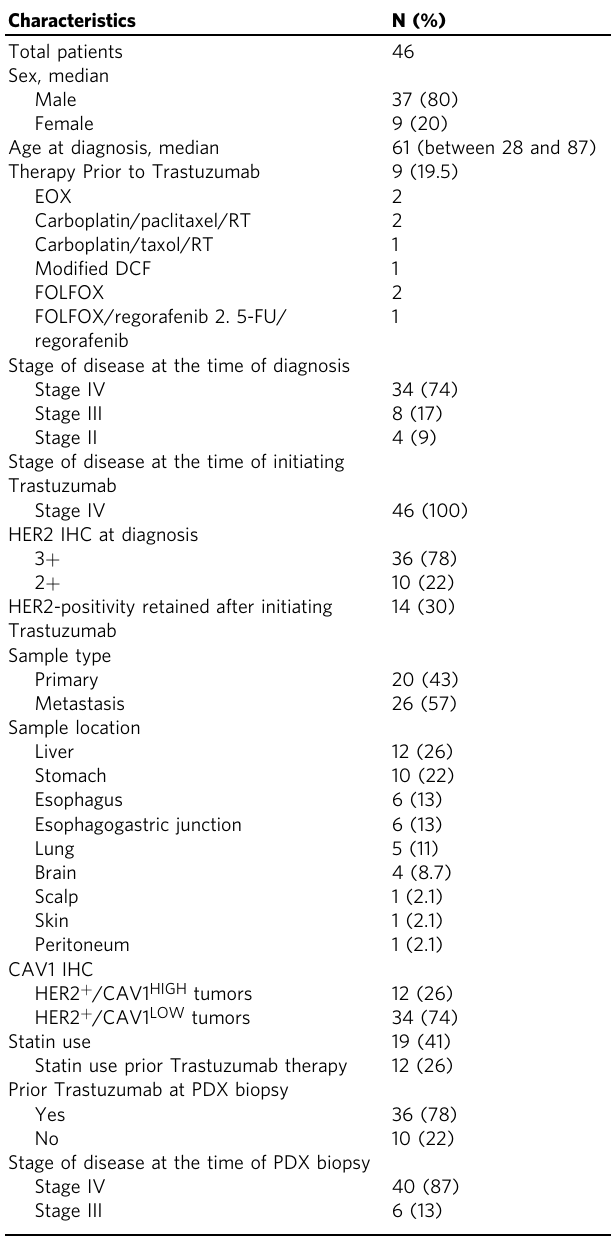
Table 1 Patient